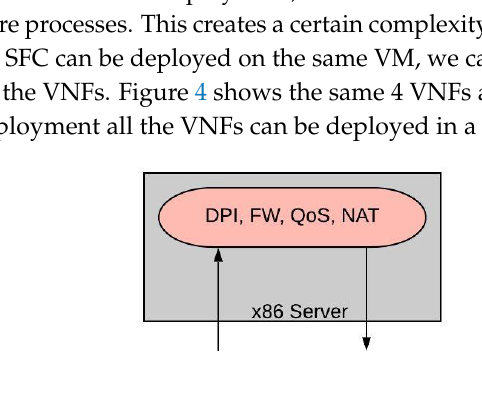
Figure 4. Multi-Feature